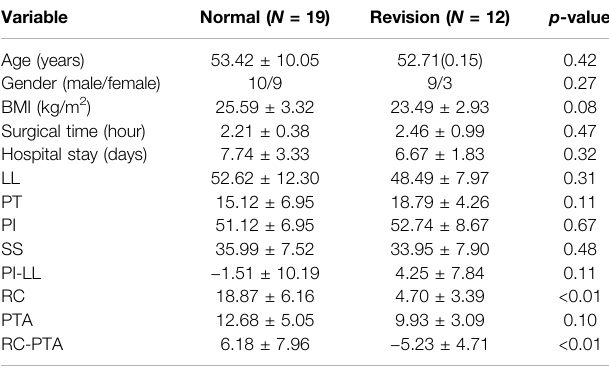
TABLE 2 | Patient demographics and radiographic parameters.